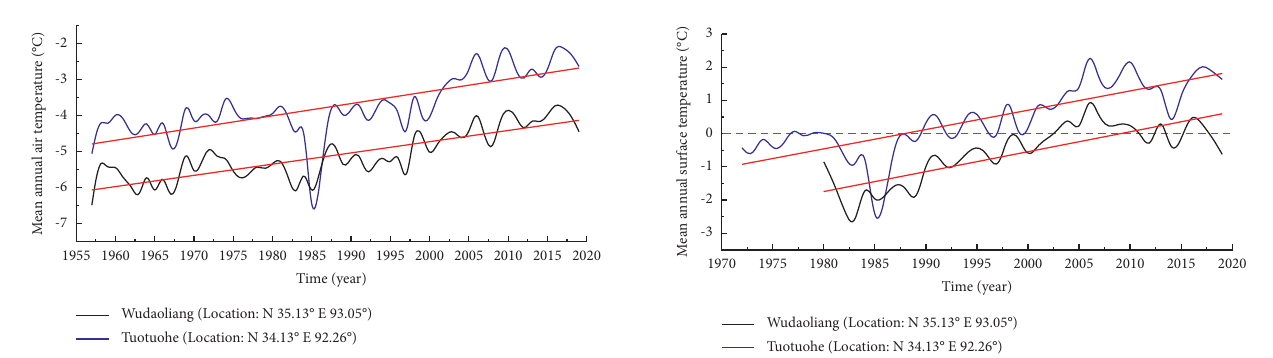
Figure 4: Variations of mean annual surface temperature at na- tional meteorological station within the QTEC from 1972 to